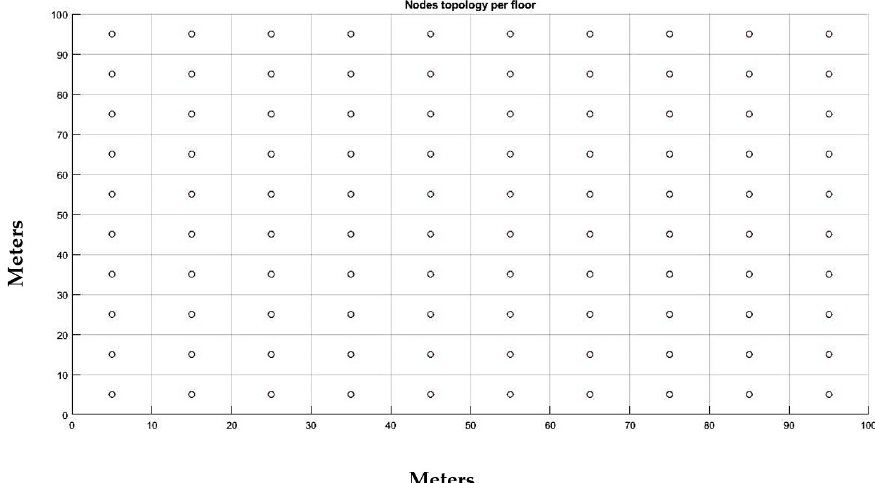
Figure 7. IAQ node deployment topology per floor.